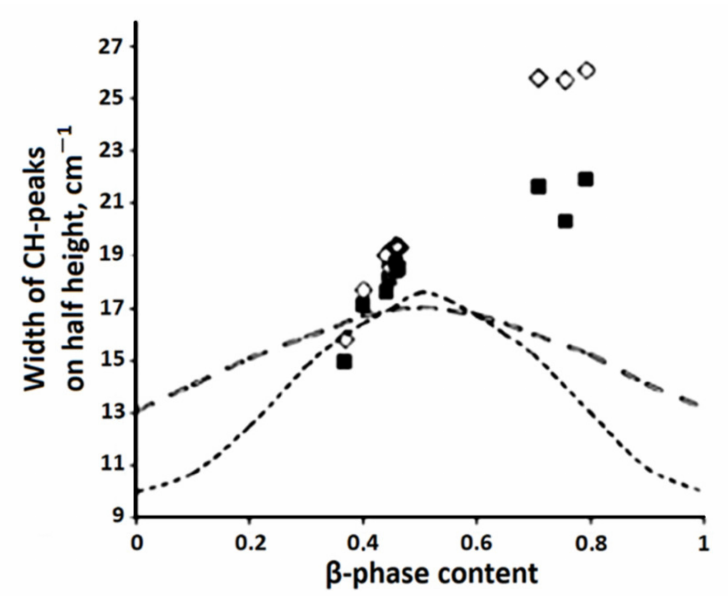
Figure 9. Change in the widths of CH peaks 1 and 2 depending on the concentration of the β phase in the model and experimental IR spectra. The designations are the same as in Figure 8